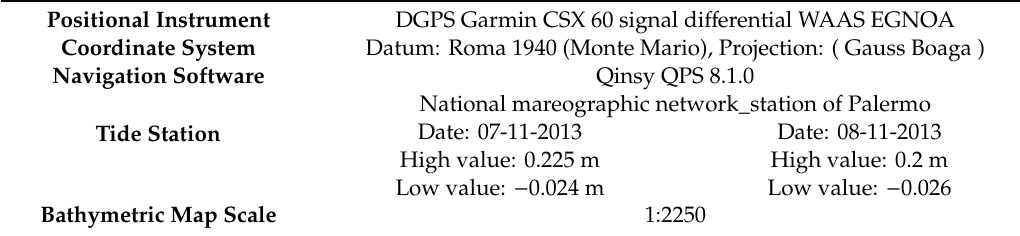
Table 2. In-situ data acquired using Single Beam Echo Sounder Garmin 550C.